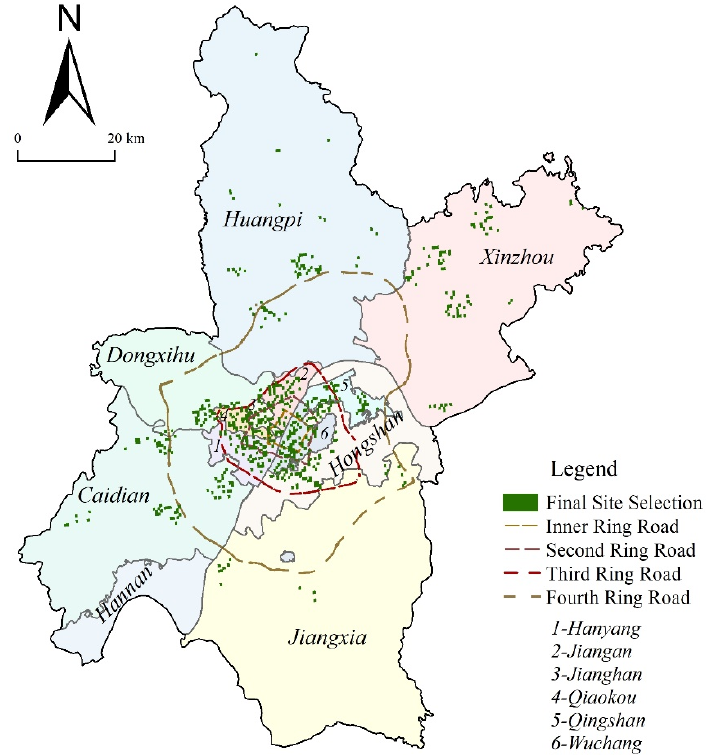
Figure 5. Areas for the new urban elderly care facilities at the street level in Wuhan,